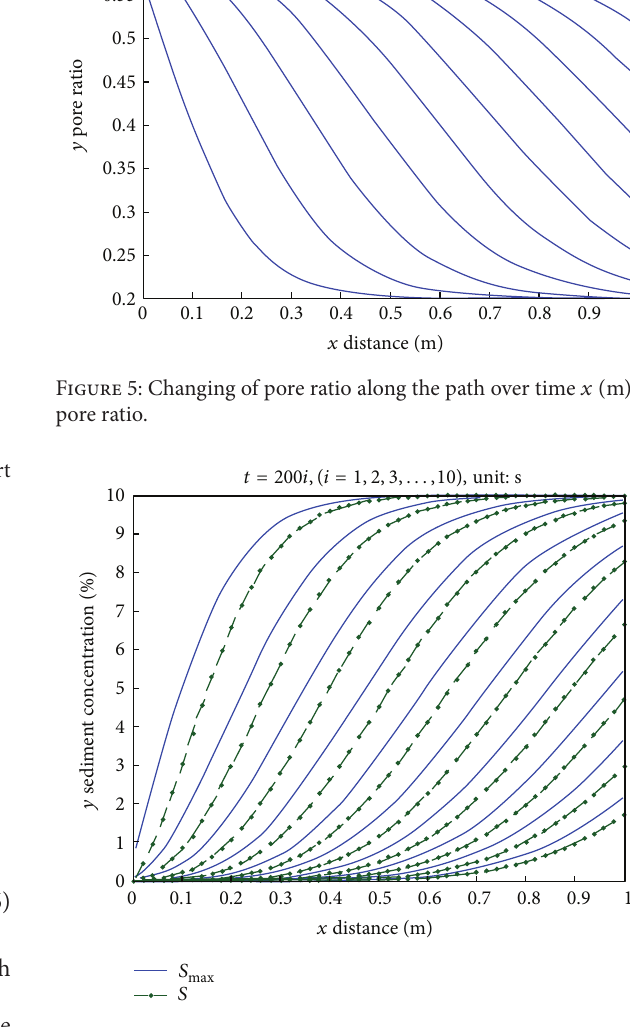
Figure 6: Changing of sediment concentration and potential sed- iment concentration along the path over time 𝑥 ( m ) , 𝑦 sediment concentration